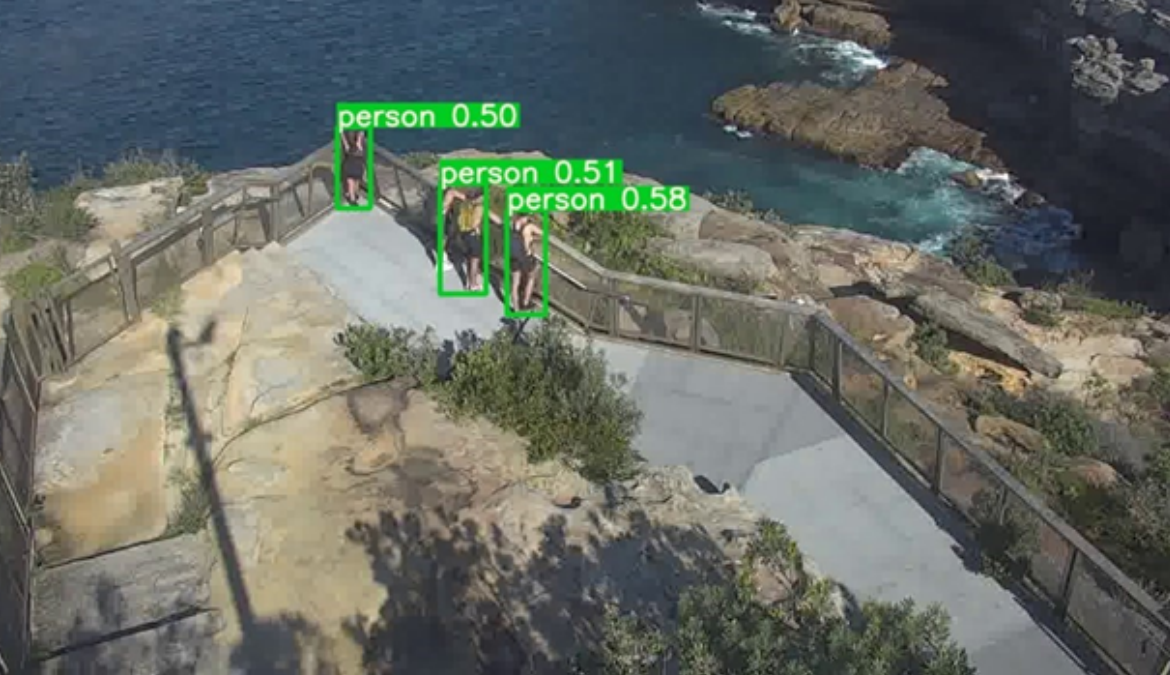
Figure 3. Pedestrian Detection Output Prior To Finetuning. Only three of the four individuals were detected, and all had low confidence values.